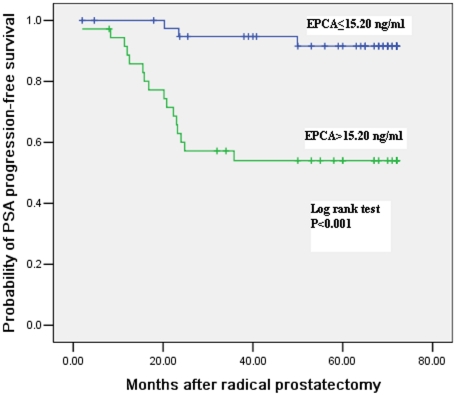
Kaplan-Meier estimates of PSA progression-free survival probability for the 77 patients with clinically localized PCa treated with RP, who were grouped by the baseline serum EPCA level above or below the median value of 15.20 ng/ml.